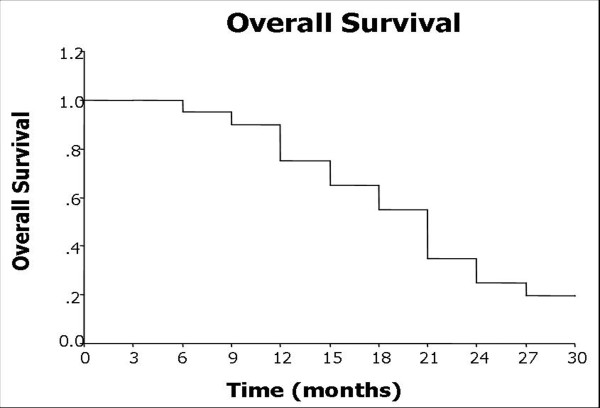
Overall survival curve after CT-guided 125I implantation.